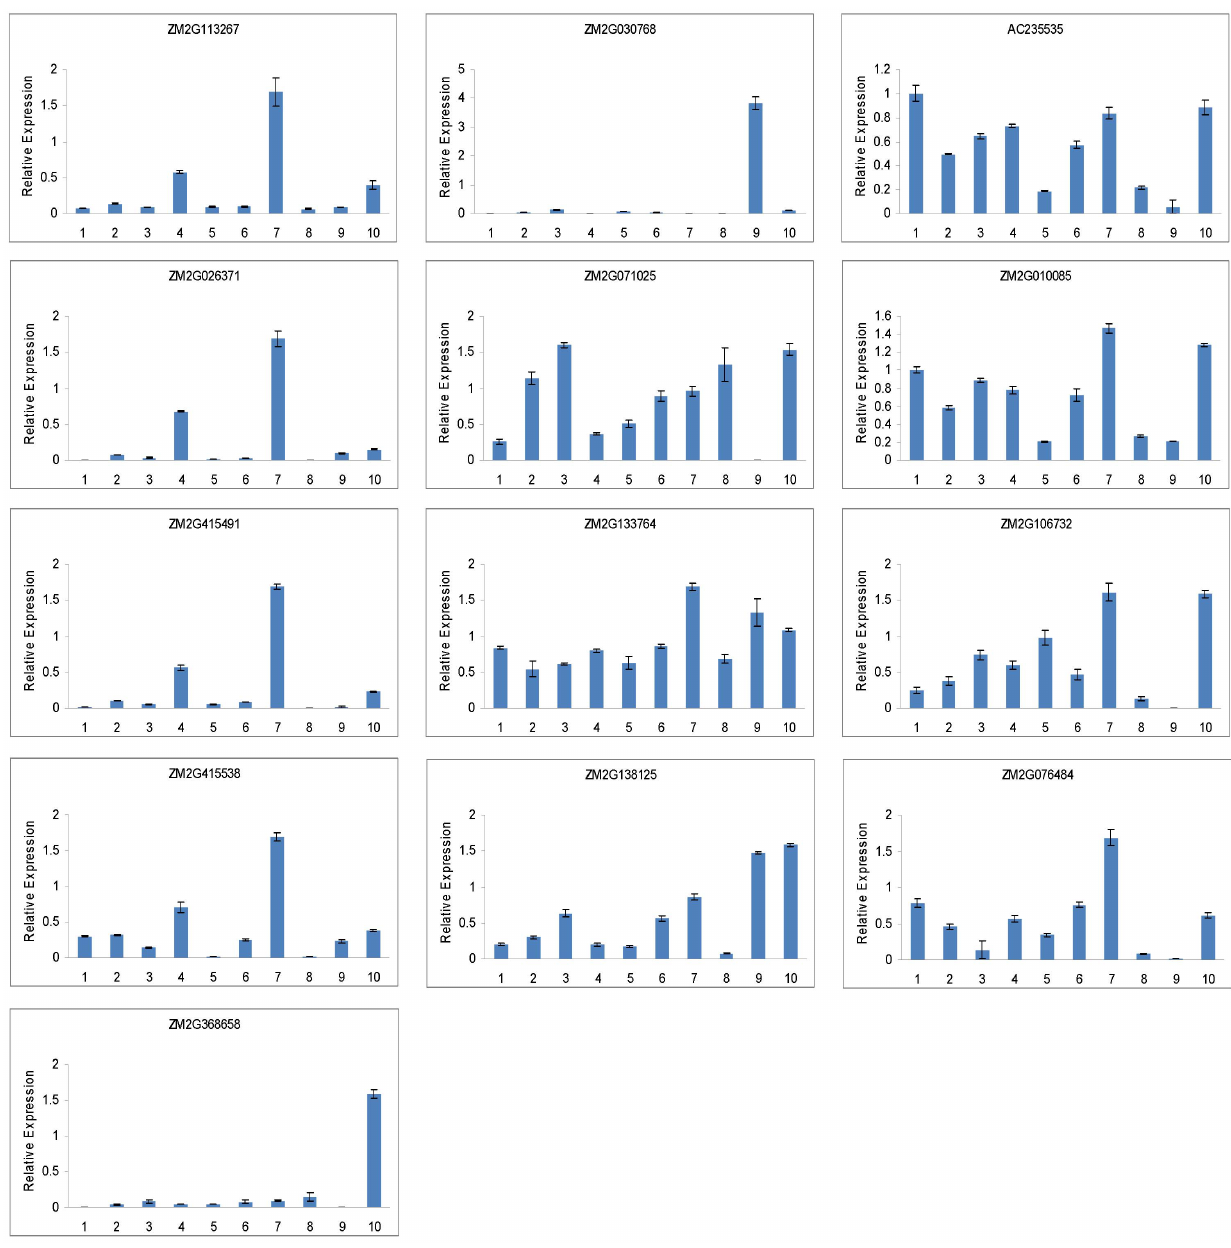
Figure 9. QRT-PCR analysis of 13 helicase genes in different tissues of Zeamays . Error bars indicate standard deviations (n=3). 1, primary root; 2, pericarp; 3, internode; 4, adult leaf; 5, silk; 6, culm; 7, seedling; 8, endosperm; 9, embryo; 10,